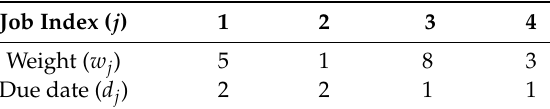
Table 1. Job data of the example